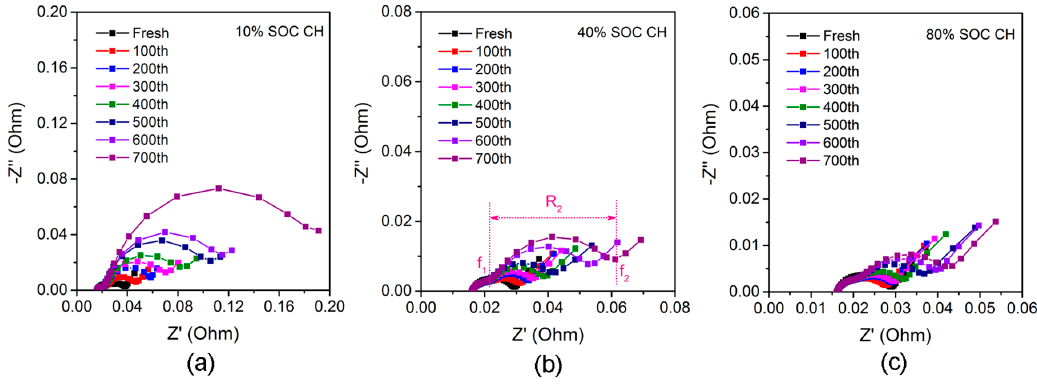
Figure 4. EIS results of the LCO + NMC532/Gr full cells at various SOC during charging: ( a ) 10% SOC; ( b ) 40% SOC; ( c ) 80% SOC.